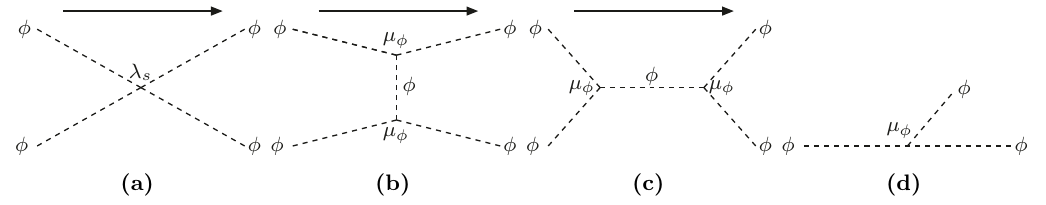
Figure 2. Diagrams relevant for the self-scattering. The diagrams (a)-(c) represent φφ → φφ processes, which are relevant for the kinetic equilibrium. The diagram (d) shows an example diagram for the collinear contributions, which is relevant for the number-changing